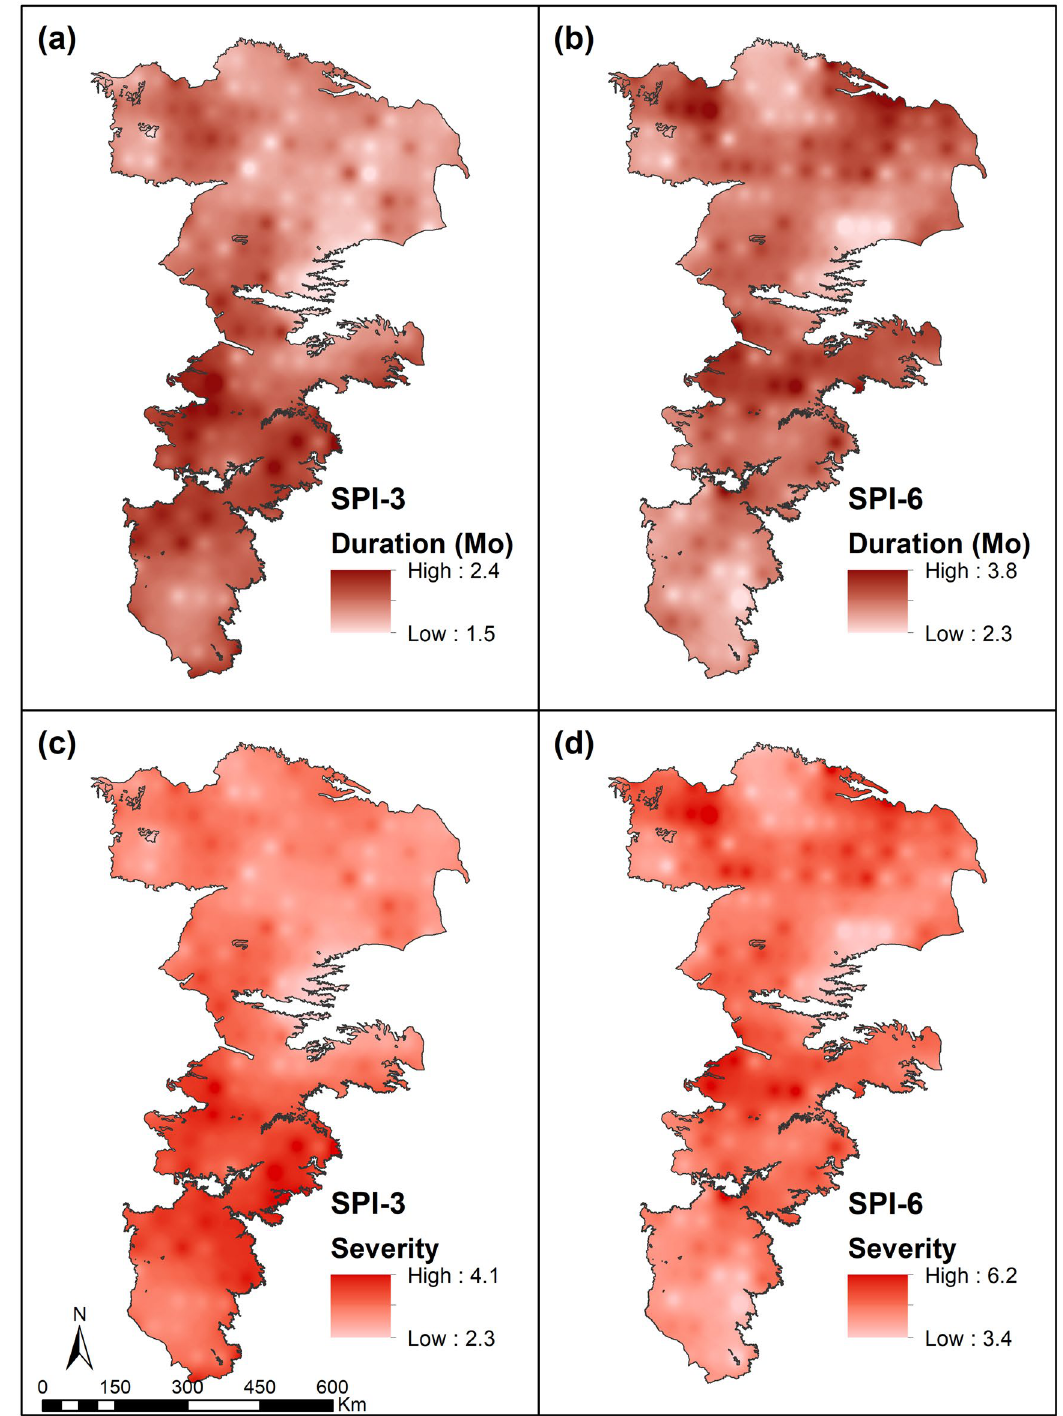
Figure 4. Expected values of absolute drought severity and drought duration for SPI at 3-month and 6-month